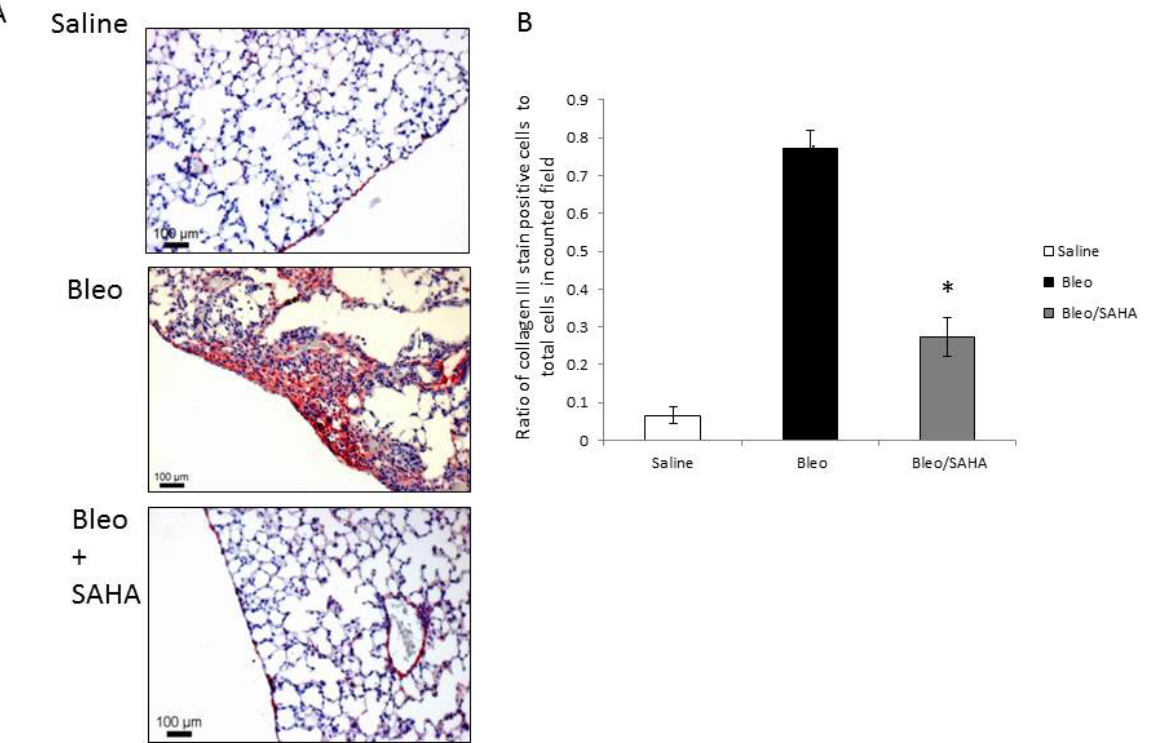
Figure 5. Collagen III in the murine model of bleomycin-induced pulmonary fibrosis with or without SAHA treatment. ( A ) Immunohistochemistry with antibody against collagen III in mice lung with saline, bleomycin and bleomycin with SAHA. Representative collagen III stained 5-µm sections of formalin-fixed, paraffin-embedded lung of six- to eight-week-old C57BL mice 28 days after intra-tracheal injection of normal saline (top), bleomycin (Bleo, middle) or bleomycin with SAHA (Bleo + SAHA, bottom) treatment every other day from day 10 to day 28 after bleomycin injury. Immunostaining of collagen III (red) is seen in large areas in the bleomycin only group. Comparatively, there is much less immunostaining of collagen III in the Bleo/SAHA treated group (bottom) compared to the bleomycin group, while little staining is observed in the saline group (a higher magnification of the figures is in the online supplementary data); ( B ) Quantitation of collagen III stained cells in randomly chosen fields relative to the total cell count in the field. The bars represent the mean ± SD of the average of at least three randomly chosen fields. * p < 0.05 vs. the bleomycin